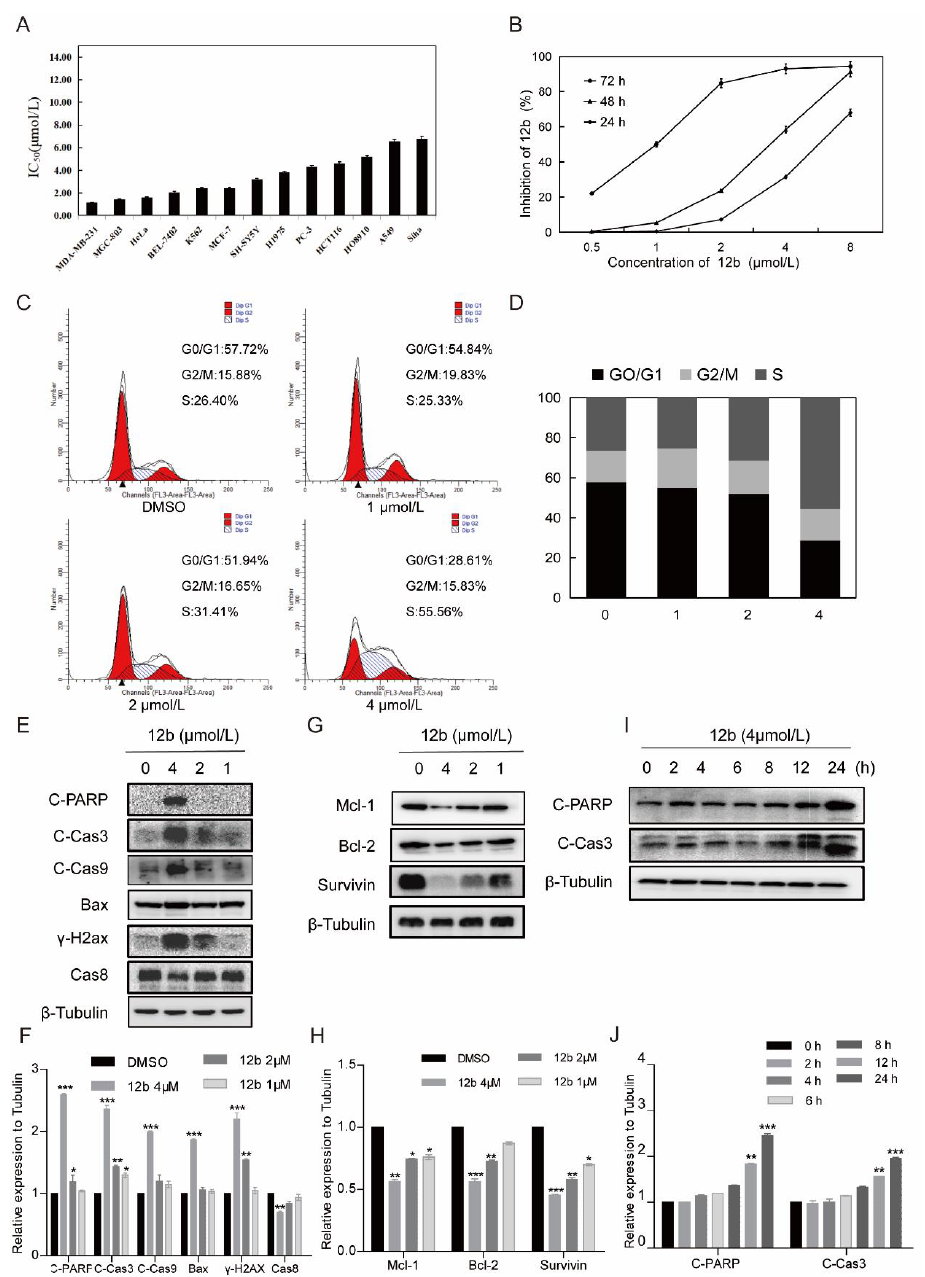
Figure 3. 12b inhibits various cells' viability and induces MDA-MB-231 cells apoptosis. ( A ) IC 50 values of 12b on various tumor cells. Cancer cells were treated with the indicated concentration of 12b for 72 h. Cell proliferation was determined by using an MTT assay. ( B ) Proliferation inhibition of 12b on MDA-MB-231 cells. Cells were treated with the indicated concentration of 1 2b for 24, 48, and